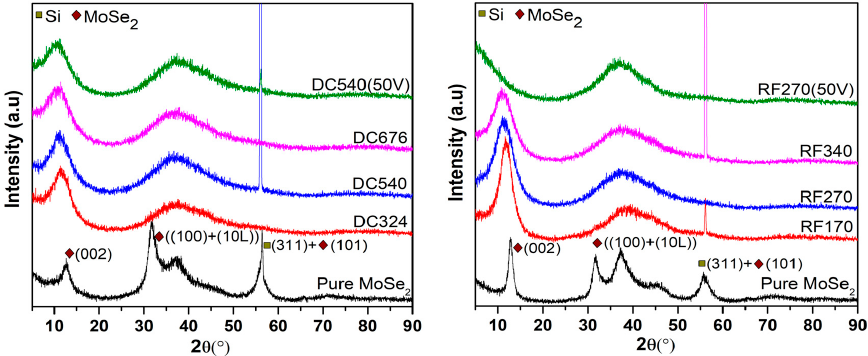
Figure 3. X-ray di ff raction patterns of the coatings (case 1-left and case Figure 3. X-ray diffraction patterns of the coatings (case 1-left and case 2-right).